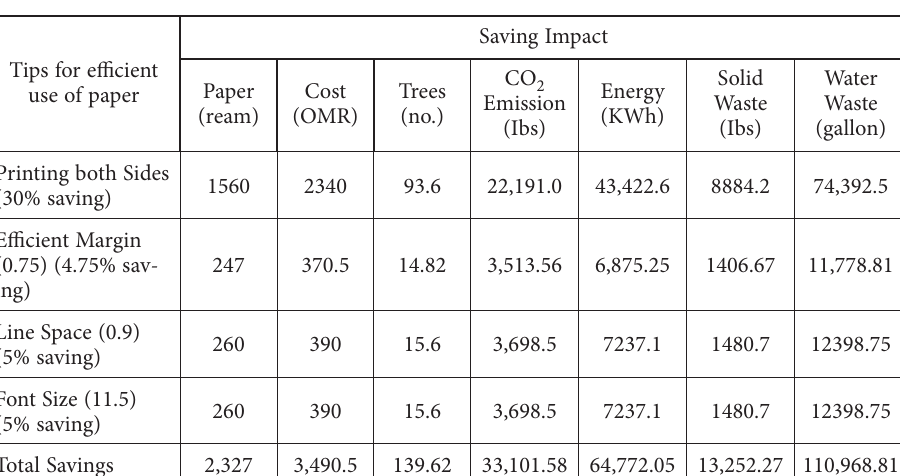
Table 8. Saving Impact of 5,200 reams (13 tons) of Paper used by three Selected Institutions in Dhofar Region in one year after Applying IT and Non-IT Tips